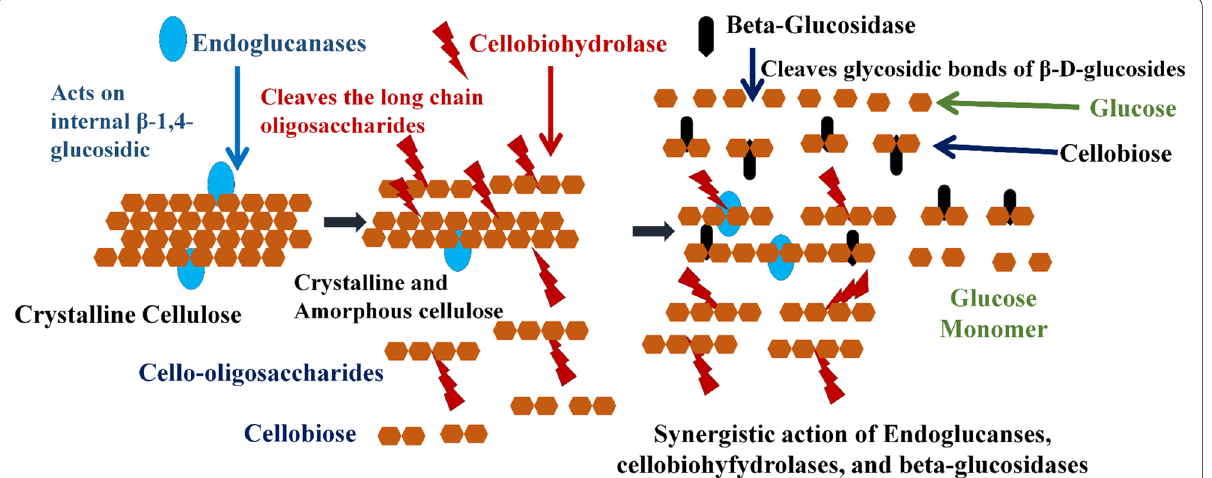
Fig. 2 Mechanism of cellulolytic enzymes (adapted with permission from Kumar and Verma